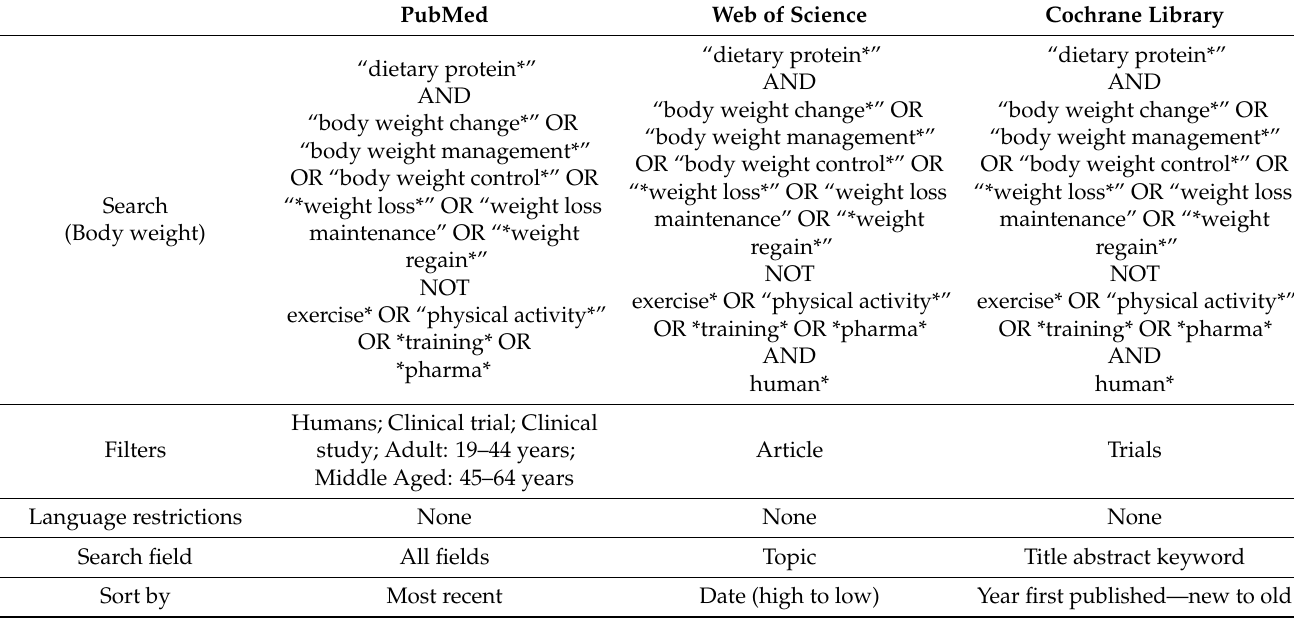
Table 1. Strategy for the primary literature search conducted to investigate the evidence for the effect of dietary protein on body weight